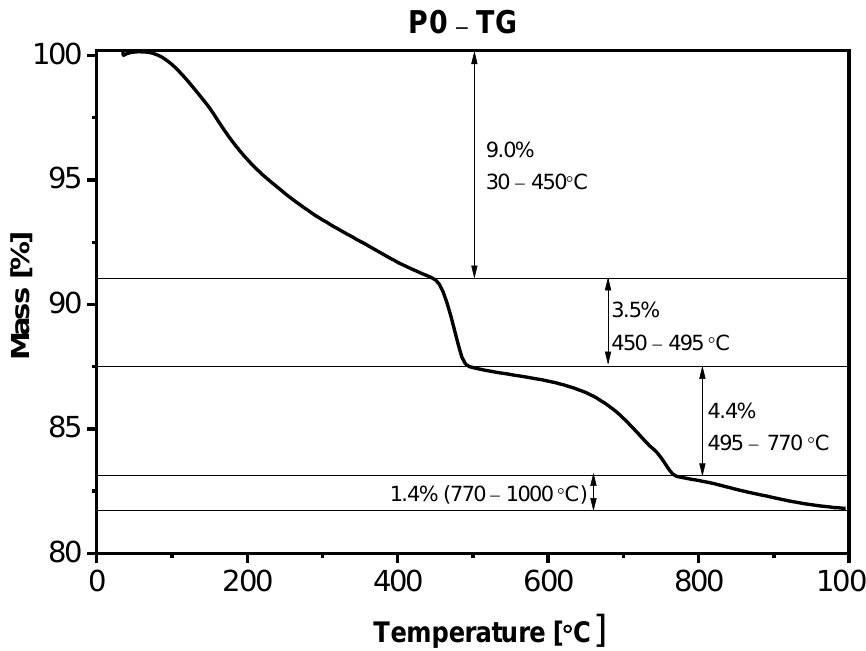
Figure 5. TGA of sample P0 after 28 days of curing.